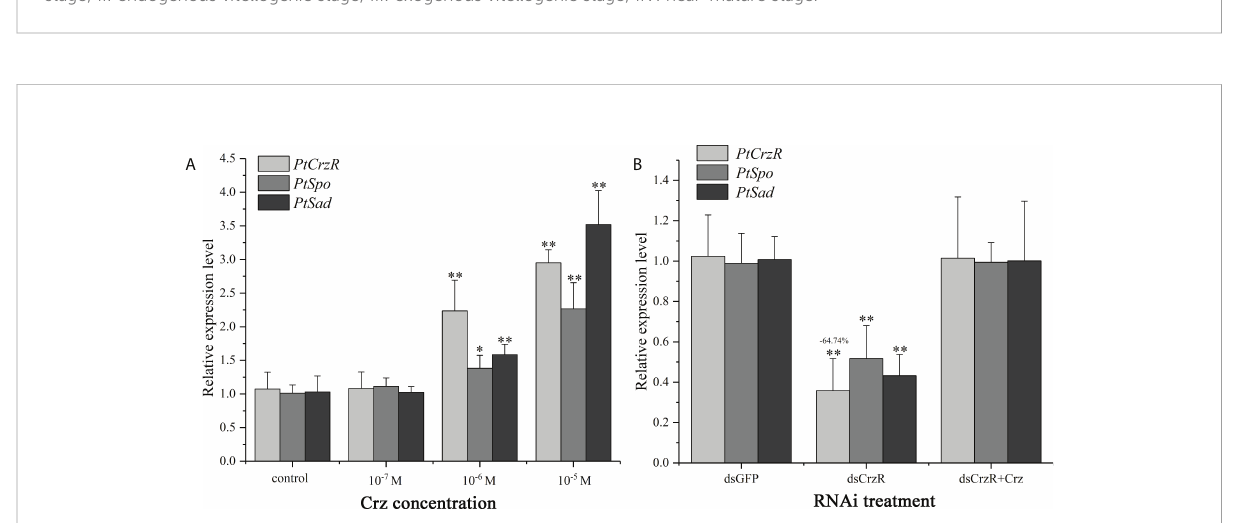
FIGURE 5 In vitro effect of synthetic Crz (A) or CrzR dsRNA (B) on the expression of PtCrzR , PtSpo , and PtSad in Y-organ explants from P. trituberculatus . Data are shown as mean ± SE (n=4). “ * ” represents signi fi cant differences ( P < 0.05) and “ ** ” represents extremely signi fi cant differences ( P < 0.01) from the control